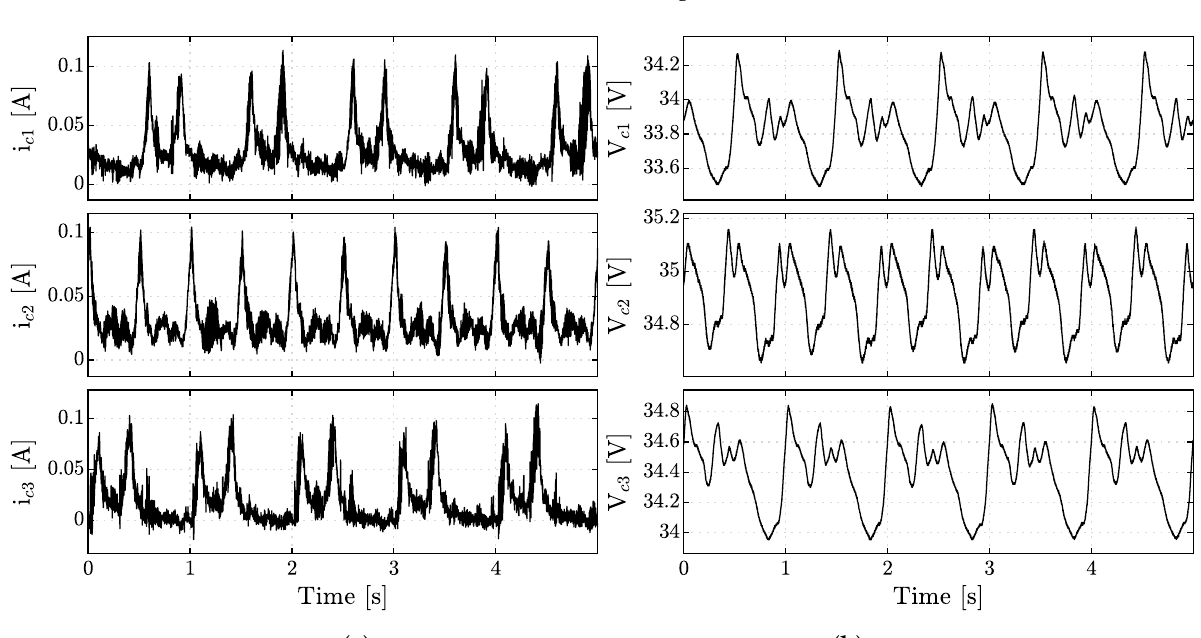
Figure 8. Experimental results. ( a ) Current flowing from the full-bridge to the capacitor ( b ) DC-link capacitor